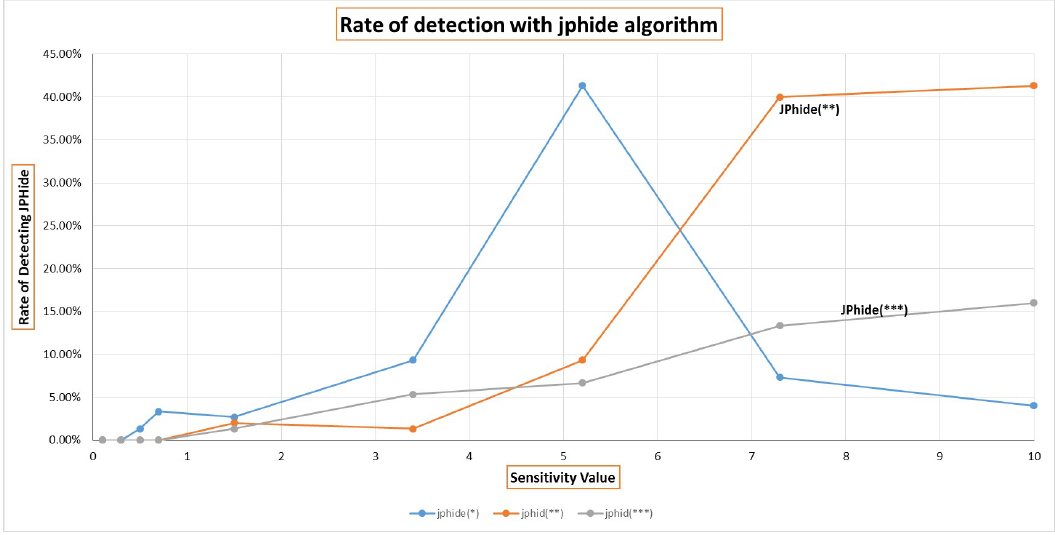
Figure 12. Changes in the jphide rate with different sensitivities for google image database (SAFE